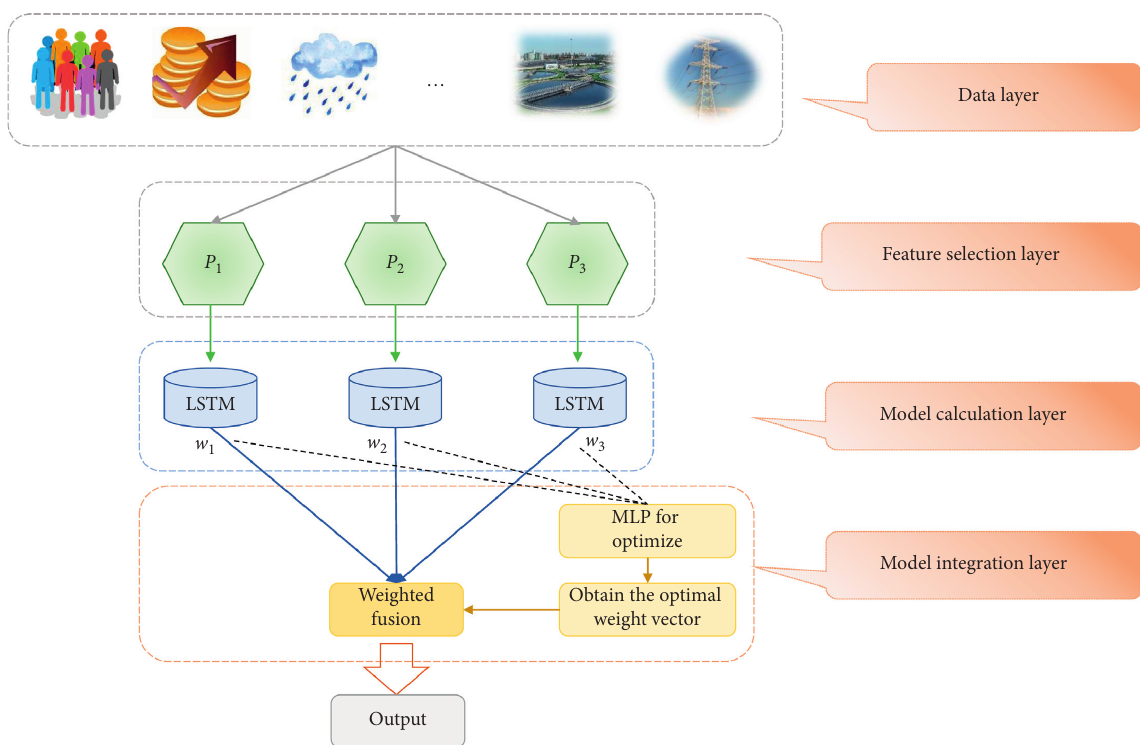
Figure 1: Framework design of the UWM-Id.